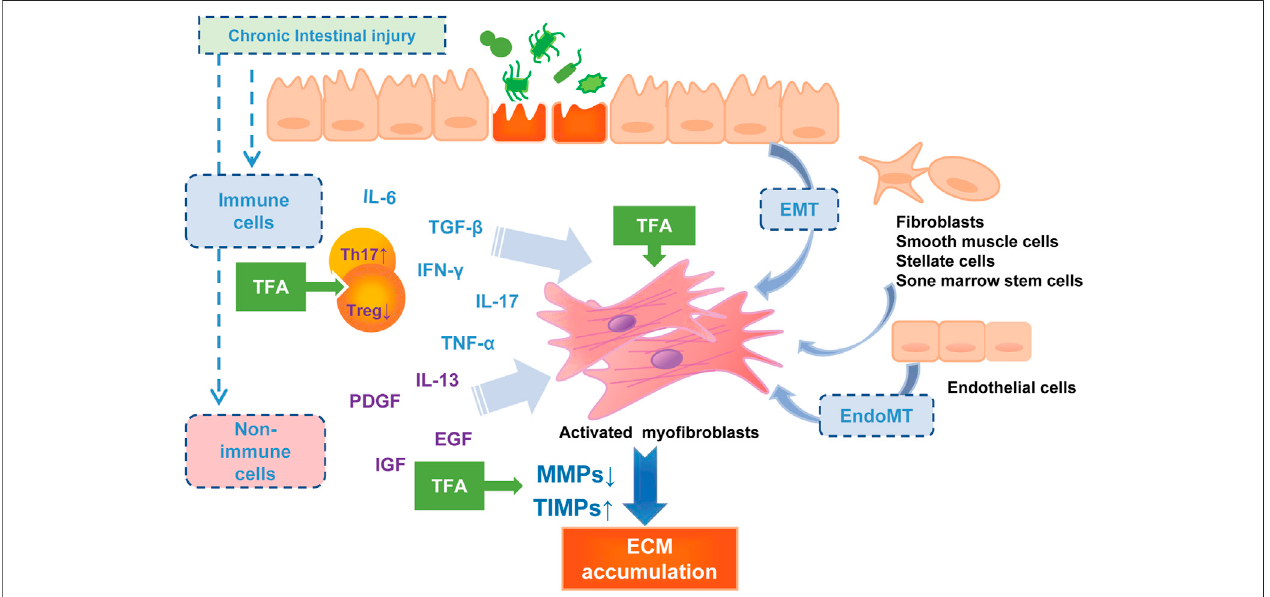
FIGURE 4 | The pathophysiology of intestinal fi brosis and the possible targets of TFA intervention. PDGF, platelet-derived growth factor; IGF, insulin-like growth factors; EGF, epidermal growth factor.